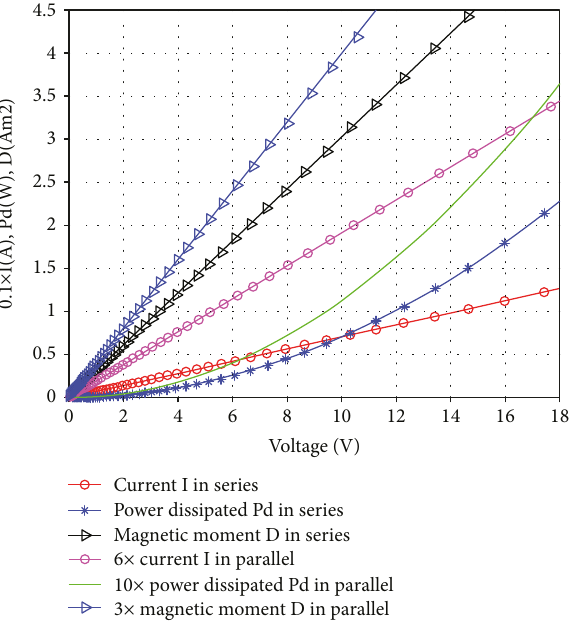
Figure 22: Voltage versus current, magnetic moment, and power dissipated for four-coil combination